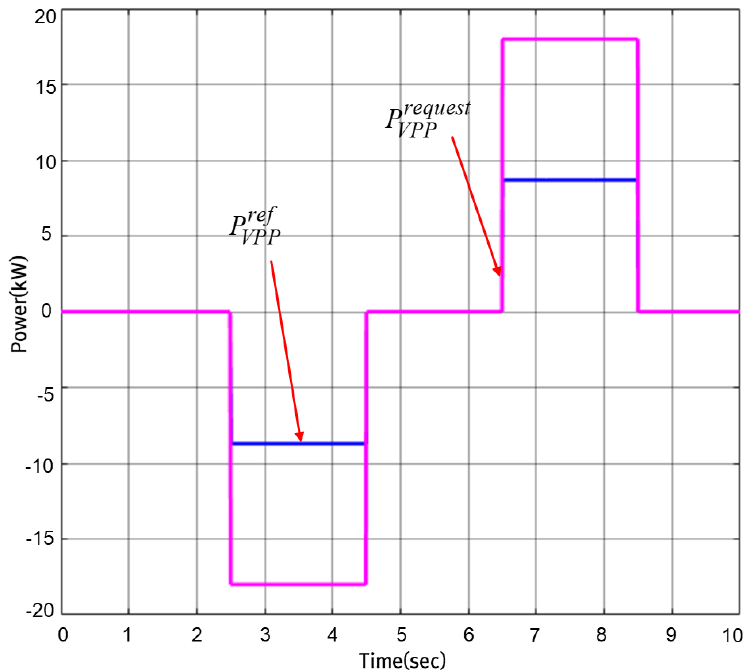
Figure 9. Comparison between the VPP’s request and the VPP’s reference.